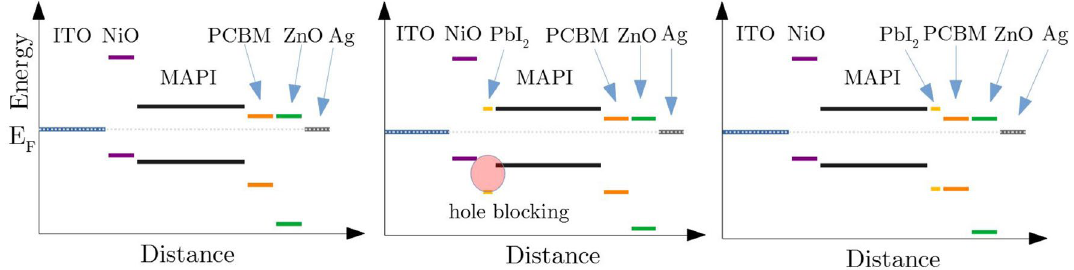
Figure 7. Schematic illustration of possible band diagrams including unconverted layers of lead iodide. The left image shows the solar cell with a fully converted MAPI absorber without residual PbI 2 (Eva 1). The middle image shows the solar cell with an additional layer of PbI 2 on top of the NiO (Eva 2). The right image shows the case of an unconverted lead iodide layer on top of the MAPI absorber (Eva 4).